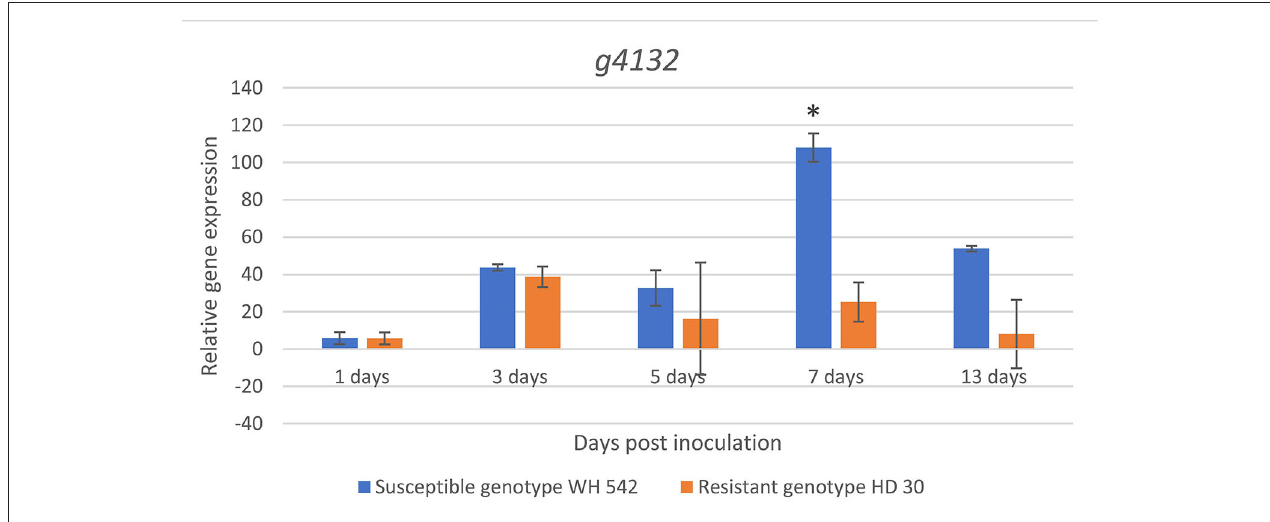
FIGURE 12 | In planta relative expression of T. indica putative effector gene upon infection in susceptible (WH542) and resistant (HD29) wheat genotypes using qPCR at different time intervals. *Statistically significant expression using unpaired t -test. on this enzyme’s plasticity. It was also reported to be important in eukaryotic cell adhesion and invasion (Matos et al.,